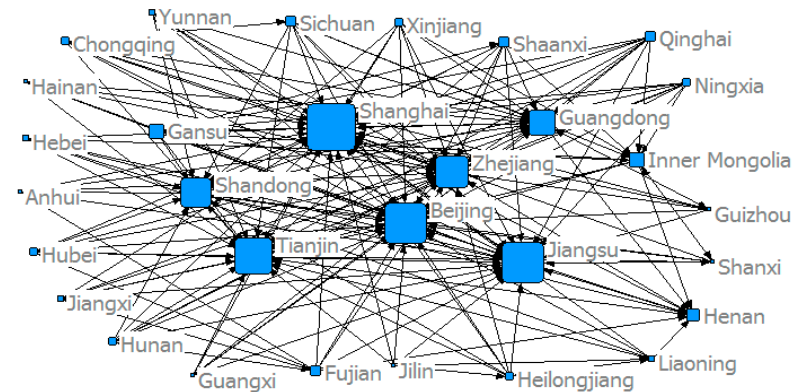
Figure 6. The structure of the ANTCE in 2010.